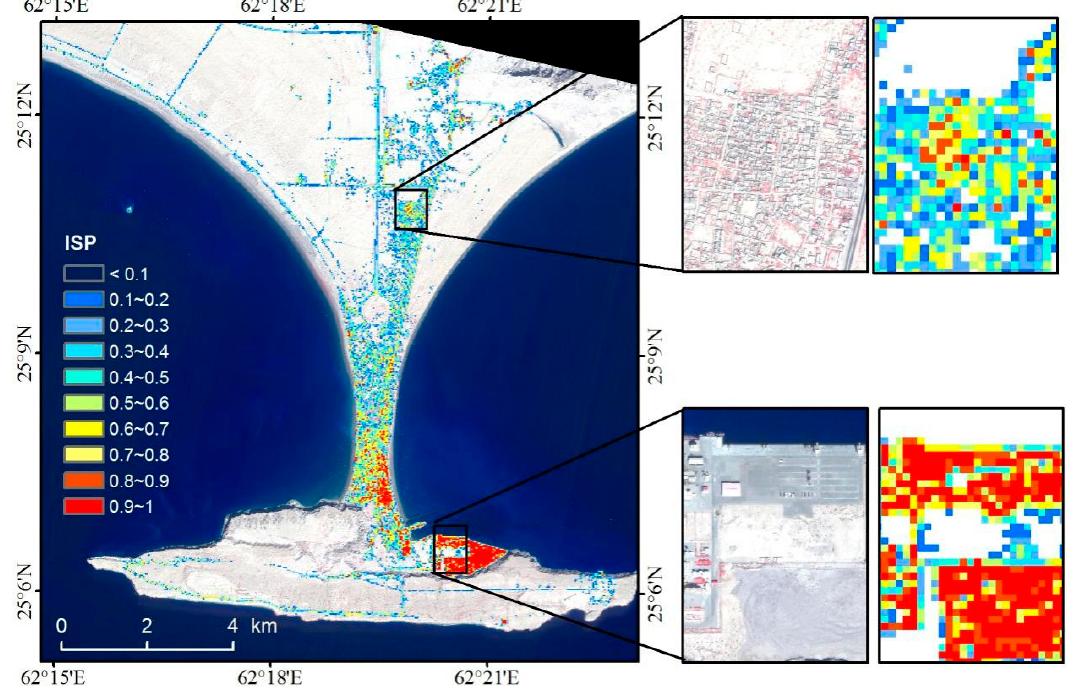
Figure 3. Impervious surface percentage (ISP) reference data extracted from GF-2 image in 2016. The background image is the standard false-color composited image from GF-2 in 2016. ISPRS Int. J. Geo-Inf. 2019 , 8 , x FOR PEER REVIEW